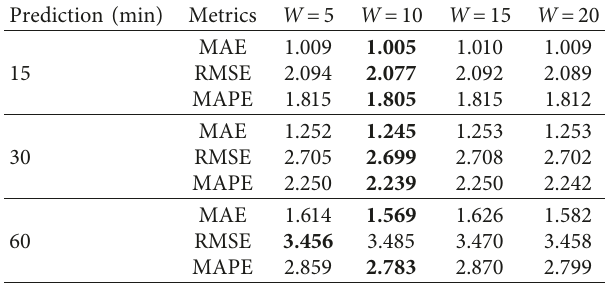
Figure 6: RMSE and MAE change with the number of hidden of the PeMSD8. Table 3: Impact of different number of DeepWalk window size on PeMSD8